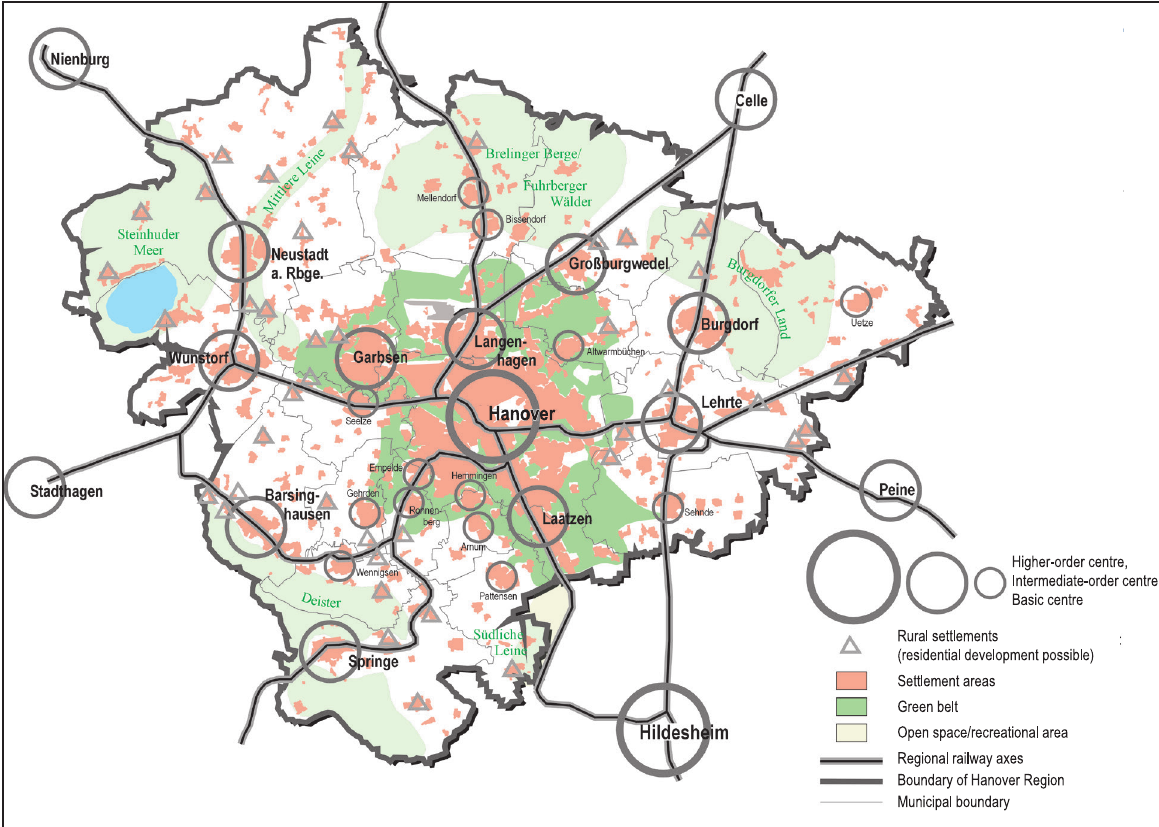
Fig. 2. Outlines of the 2005 spatial development programme ( Regionales Raumordnungsprogramm 2005 ) Source: Region Hannover (ed.): Regionales Raumordnungsprogramm 2005 . Hannover 2005 (legend translated by Axel